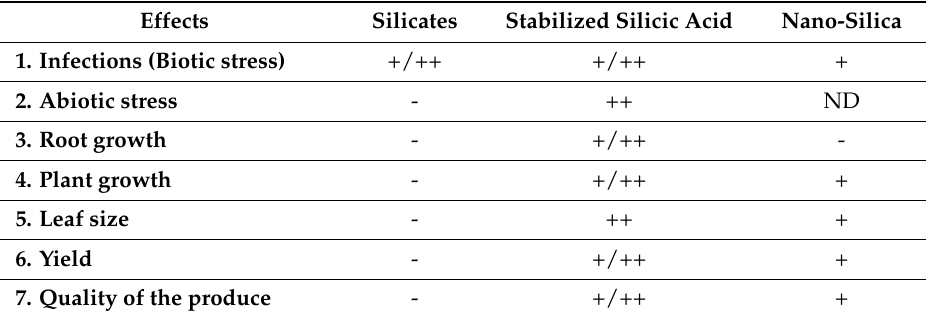
Table 3. Schematic overview of the effects of the different foliar sprays with (a) silicates; (b) stabilized silicic acid; and (c) nano-silica on 1. Infections (biotic stress), 2. Abiotic stress, 3. Root growth, 4. Plant growth, 5. Leaf size, 6. Yield and 7. Quality of the produce. The symbols used in these columns